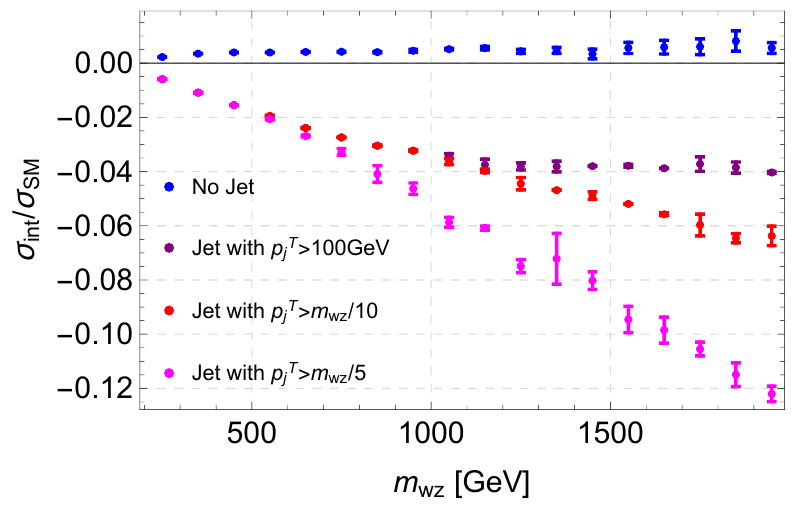
Figure 4 . (cid:27) int =(cid:27) SM as a function of m WZ for the process pp ! WZ (blue) and the process pp ! V W + j , with p T > m WZ = 5 (pink), p T > m WZ = 10 (red), and p T j j